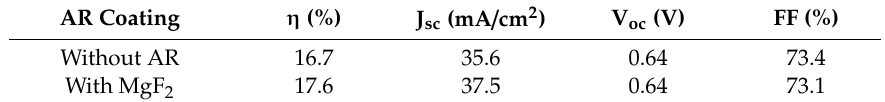
Figure 6. Comparison of measured ( a ) current–voltage (J–V) characteristics under simulated 1-sun illuminations and ( b ) QE spectra obtained for CIGS solar cells with and without the AR coating. Table 1. Device parameters of the CIGS solar cell before and after depositing the AR coating.